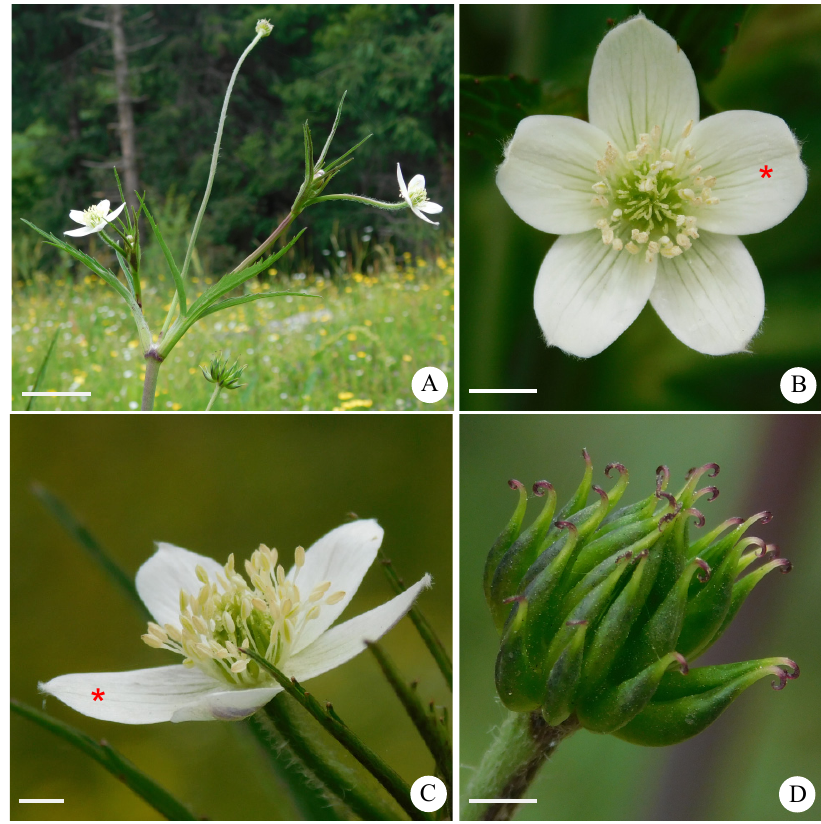
Figure 1. Mature and normal flowers and young fruit of Anemone barbulata . ( A ) Inflorescence (cyme). ( B ) Top view of a normal flower. A red star indicates one of the five sepals. ( C ) Side view of a normal flower. A red star indicates one of the five sepals. ( D ) Side view of young fruit. Scale bar = 1.5 cm ( A ) and 0.3 cm ( B – D ).